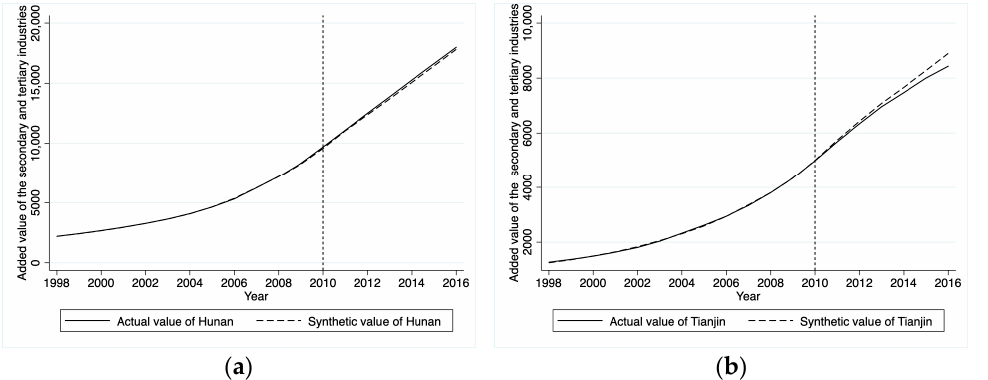
Figure 9. Synthetic control results of disposal groups: actual and synthetic values of ( a ) Hunan; ( b ) Tianjin.